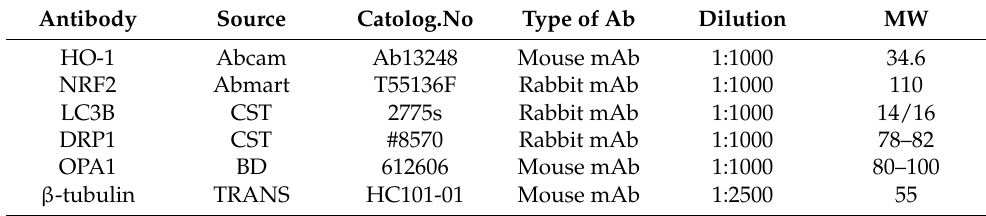
Table 1. Primary antibodies used in the study. Antibody Source